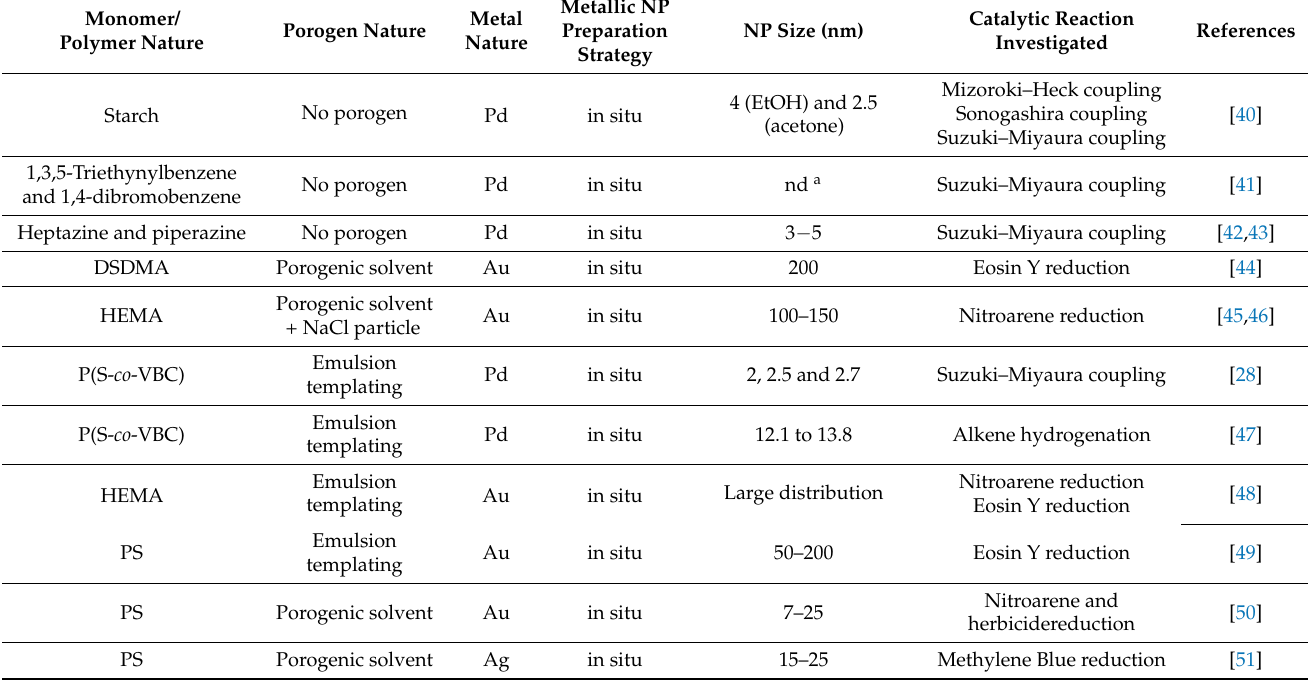
Table 1. Summary of the more significant catalytic molecular reactions achieved using hybrid materials prepared from metallic NPs and porous polymeric